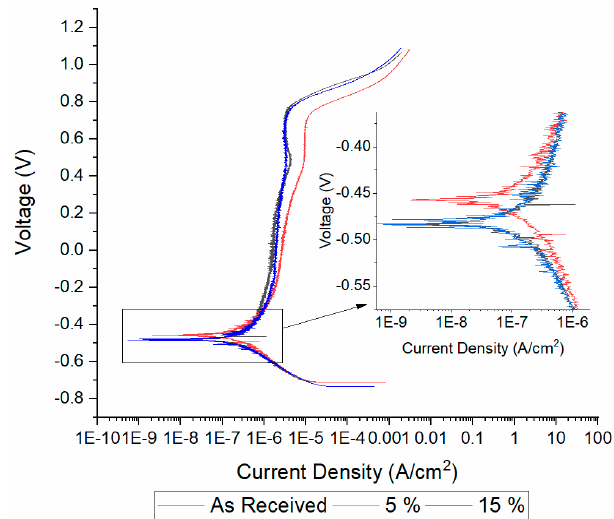
Figure 8. Potentiodynamic polarization curves of tested materials.